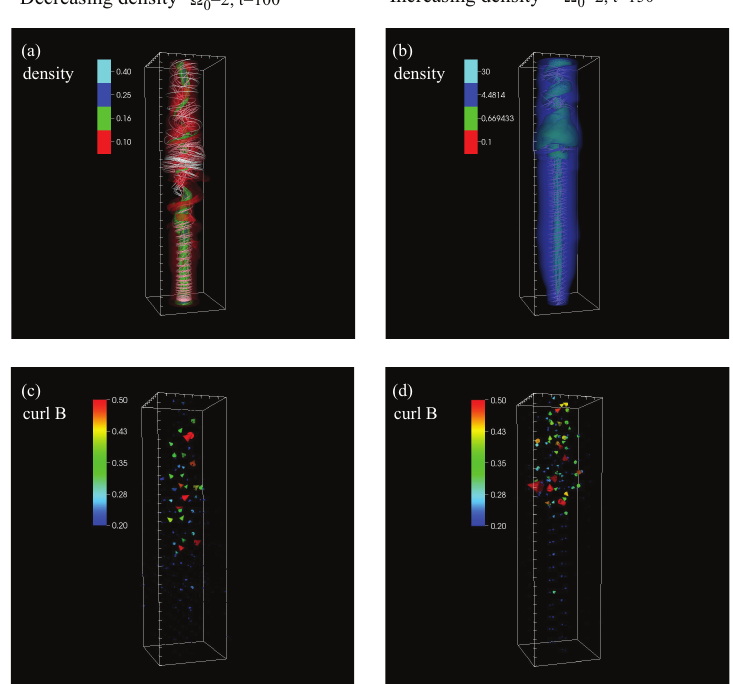
Figure 1. upper: 3D density isosurfaces and lower: the locations of maximum current density, curlB for ( a , c ) the decreasing density model with Ω 0 = 1 at t s = 100 and ( b , d ) the increasing density model with Ω 0 = 2 at t s = 150 of CD kink instability in relativistic rotating jets. The solid lines correspond to the magnetic field lines. The current density traces the regions where magnetic reconnection may occur, at the same time. Figure taken from